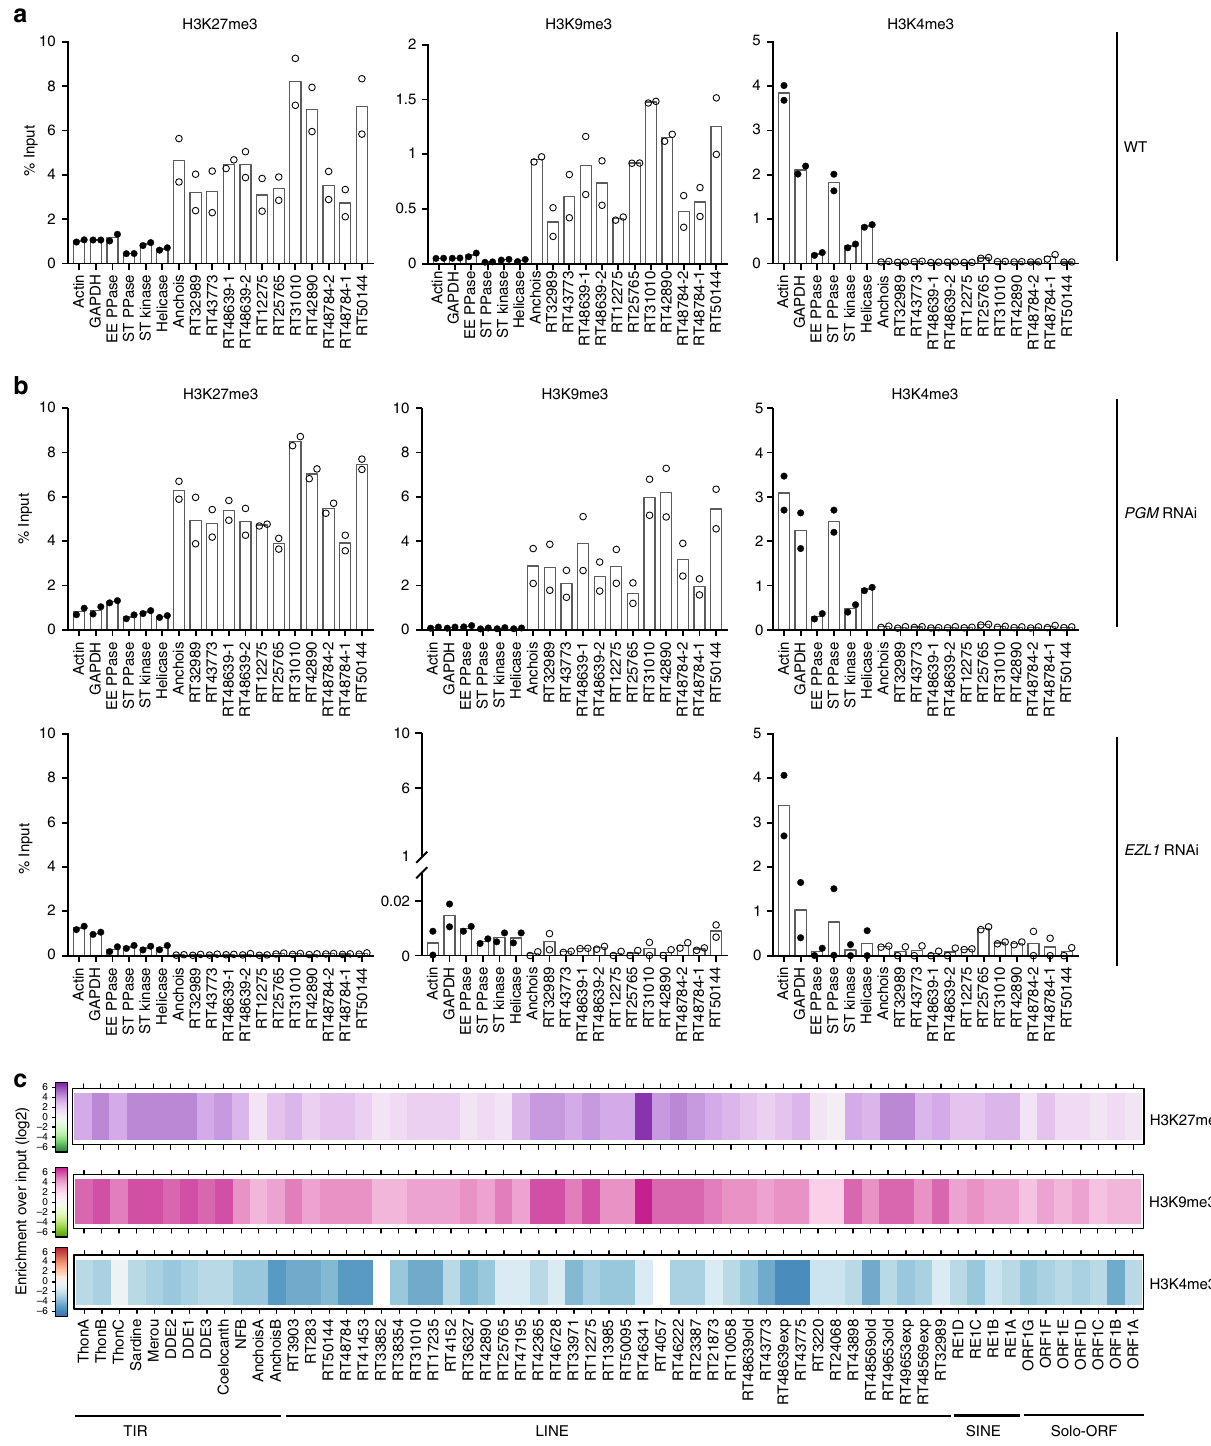
Fig. 5 H3K27me3 and H3K9me3 mark the same transposable element copies in an Ezl1-dependent manner. a H3K9me3, H3K27me3, and H3K4me3 enrichment at individual copies from different TE families at an early stage of development (at 10 h after the onset of sexual events) in wild-type cells as measured by ChIP-qPCR. Quantitative data are expressed as the percentage of ChIP over Input. ACTIN , GAPDH , EE PPASE , ST PPASE , ST KINASE , and HELICASE are control genes (Supplementary Table 4 for accession numbers and primers). According to the RNA-seq analysis, Anchois (TIR), RT31010; RT42890; RT50144; RT48784 – 1; RT48639 – 1; RT48639 – 2 (LINEs) are signi fi cantly upregulated upon EZL1 RNAi, whereas RT25765; RT12275; RT32989; RT43773; RT48784 – 1 (LINEs) are not. Circles (black for genes; white for TEs) indicate the individual data points. Horizontal bars represent the mean of biological replicates. b H3K9me3, H3K27me3, and H3K4me3 enrichment at the same individual TE copies at a late stage of development (50 h after the onset of sexual events) upon PGM (top panel) or EZL1 (bottom panel) RNAi as measured by ChIP-qPCR. Data are represented as in a . c Heatmap of H3K27me3, H3K9me3, and H3K4me3 enrichment for 61 TE families determined by ChIP-seq of two biological replicates. Colors represent the